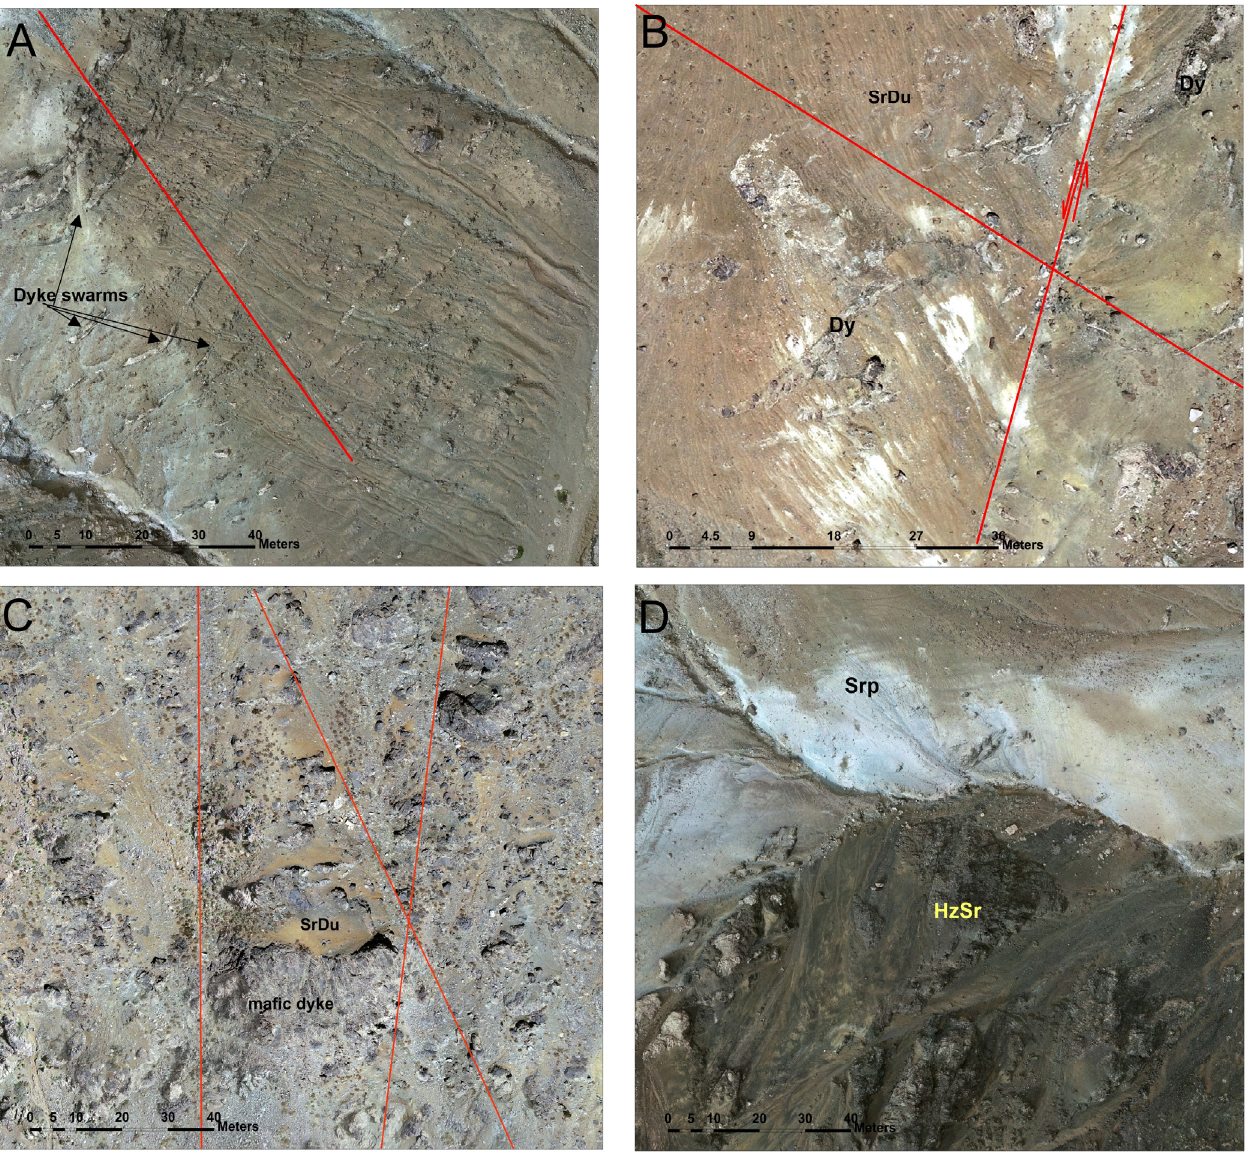
Figure 8. The close view of the orthomosaic for four parts of the surveyed area. Note the thickness of dykes which in some cases are smaller than 1 m, while they can be digitized. ( A ) the highly serpentinized peridotite with intruded swarm dykes (also marked as serpentinite1, see SVM section) ( B ) Serpentinite with iron-rich (limonitic) crust and faulted dykes (serpentinite2, SVM section). ( C ) the close view of the cumulate unit (Dcu unit), including mafic dykes and layered gabbros with discordant serpentinized dunitic (SrDu) lenses (cumulate unit in SVM section). ( D ) The boundary between moderately serpentinized peridotite (bottom, HzSr) and serpentinite (Srp) is clearly recognized on the basis of color and texture differences. The red lines show the faults. The abbreviations used in this figure and following figures are the same with the final geological map. The higher resolution of images is included in the supplementary material Figure